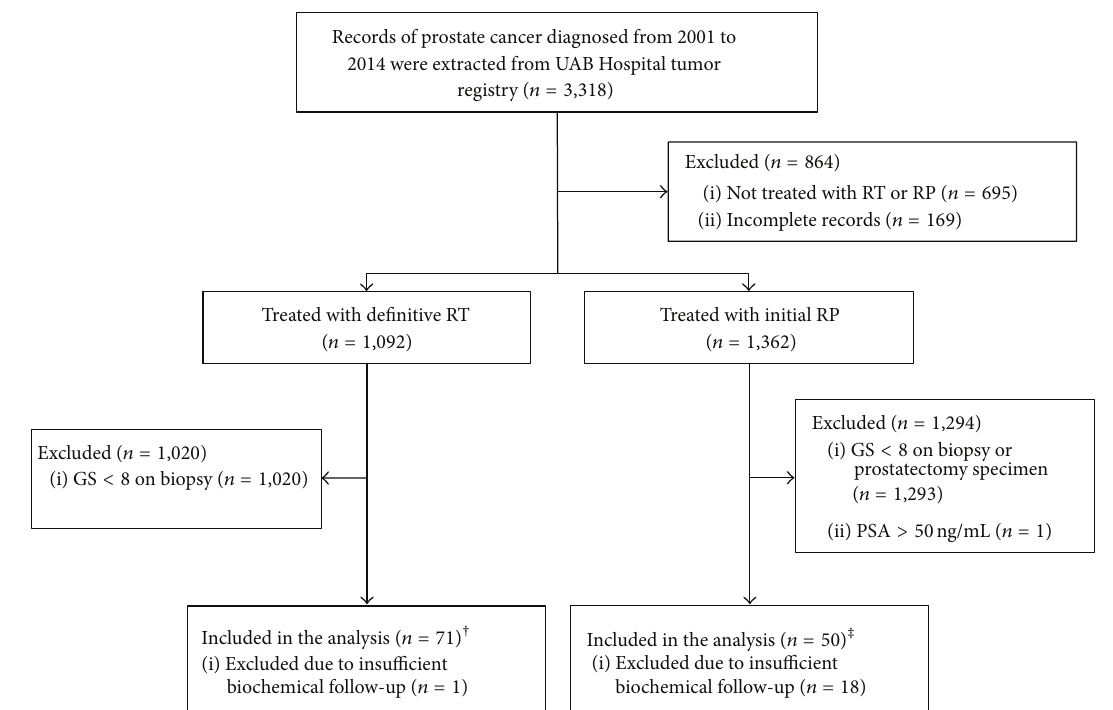
Figure 1: Consolidated Standards of Reporting Trials diagram. † 68/71 patients received neoadjuvant and/or adjuvant ADT; 1/71 received adjuvant chemotherapy. ‡ 22/50 patients received adjuvant RT; 12/50 received salvage RT; 1/50 received adjuvant